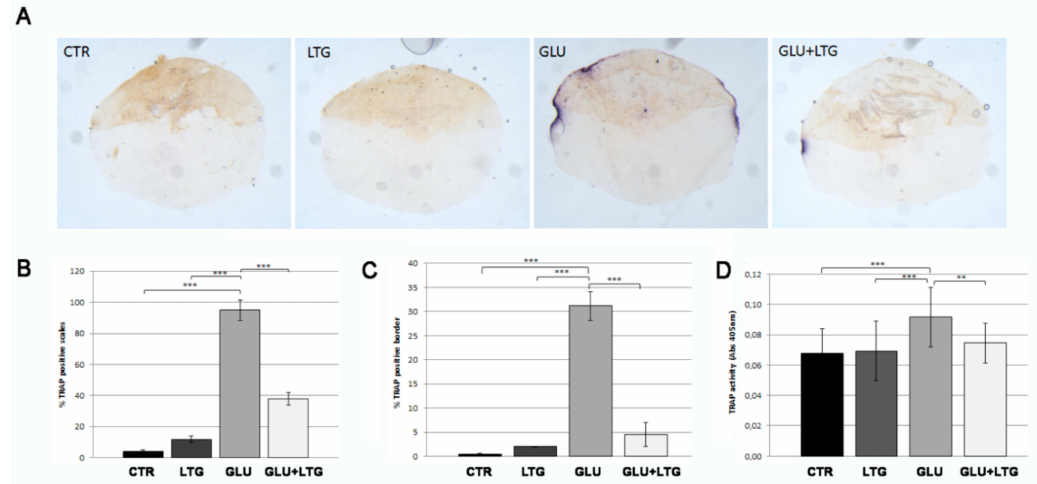
Figure 3. ( A ) Histological TRAP activity assay. Enzymatic activity along scale border of CTR scales or treated with LTG, GLU, and GLU + LTG can be visualized by violet staining. ( B ) Percentage of TRAP-positive scales (CTR vs. GLU, p < 0.001) (GLU + LTG vs. GLU, p < 0.001). ( C ) TRAP-activity extension calculation among TRAP-positive scales, (CTR vs. GLU, p < 0.001) (GLU + LTG vs. GLU, p < 0.001). ( D ) Biochemical TRAP assay. Quantification of TRAP activity was performed on same samples with a biochemical assay (CTR vs. GLU, p < 0.001; GLU + LTG vs. GLU, p < 0.001). p < 0.01 (**) and p < 0.001 (***).